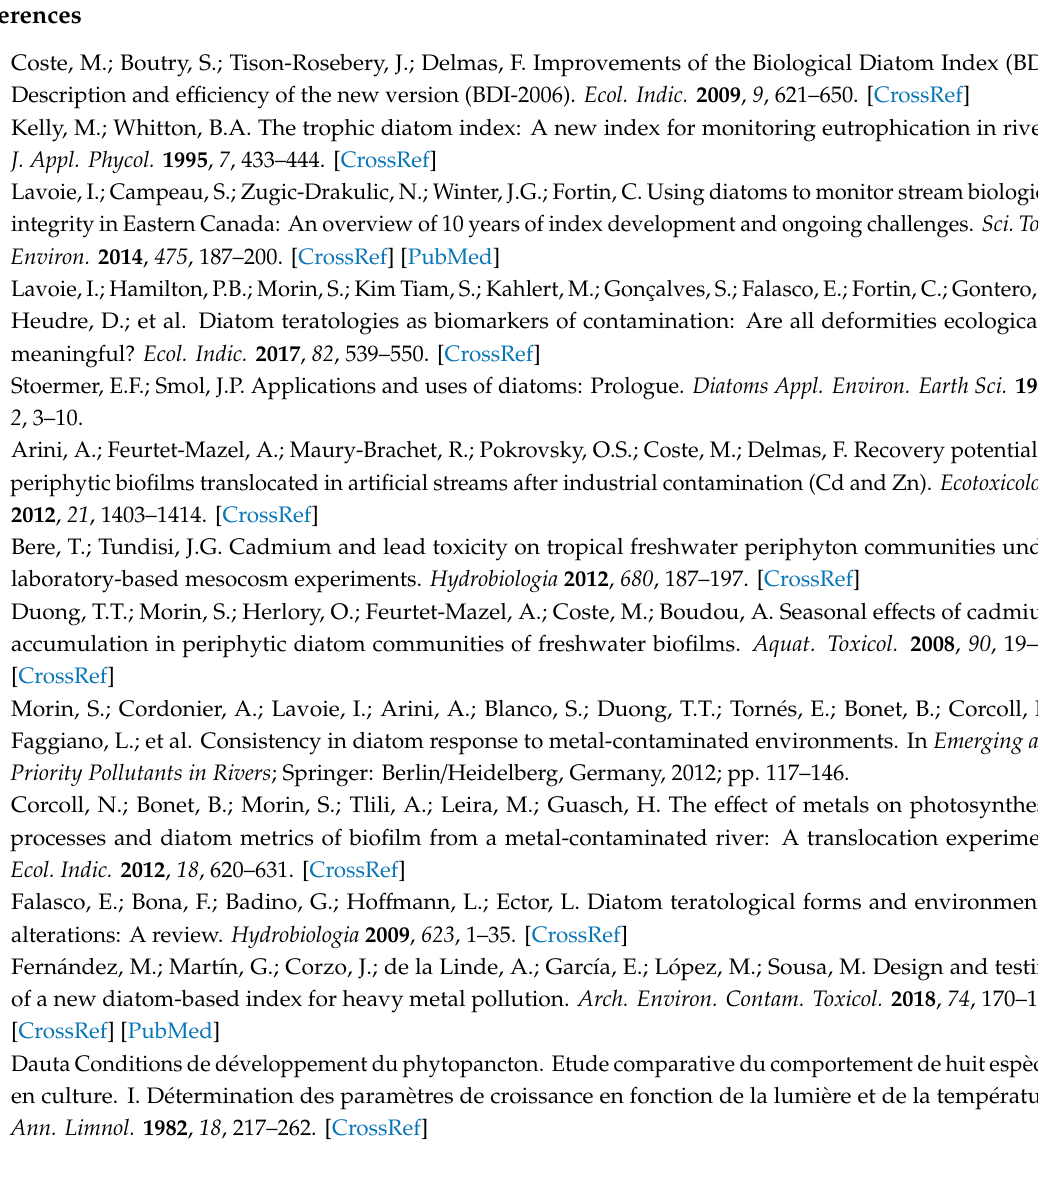
Supplementary Information 1. Flow chart illustrating sample management and analytical measurements during the chronic